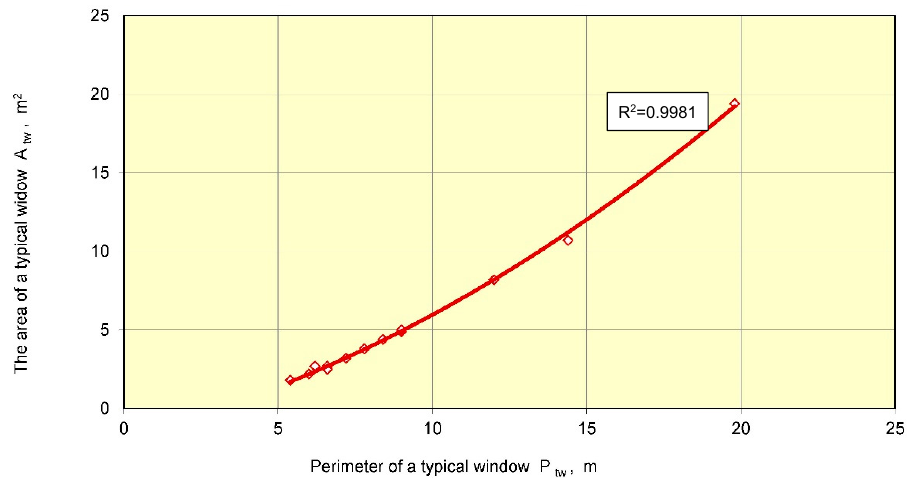
Figure 4. Relations between the area of a typical window A tw and perimeter of a typical window P tw in education buildings.